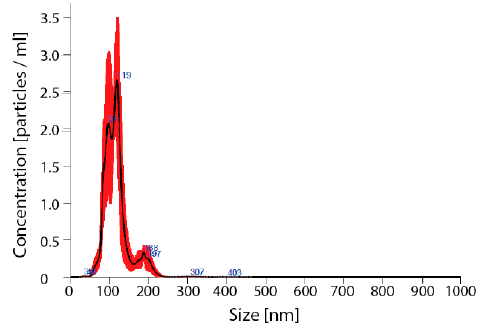
Figure 5. Verification of nanoparticles as exosomes. Nano sight for nanoparticles size; avg 115 ± 7, mode 111 ± 6 nm, SD 27 ± 3.